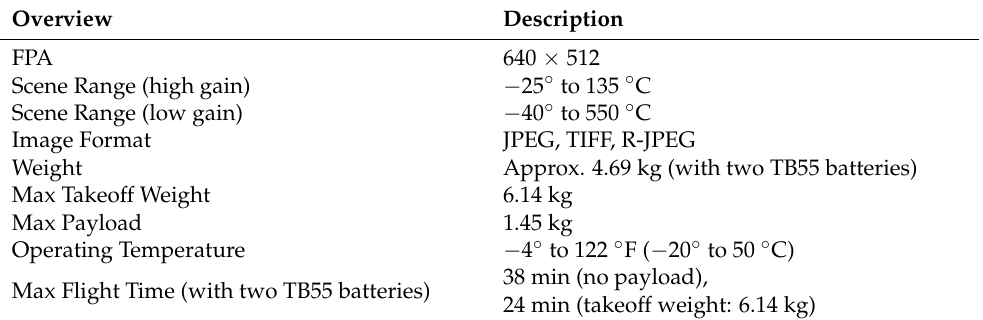
Table 1. UAV and thermal camera specification.